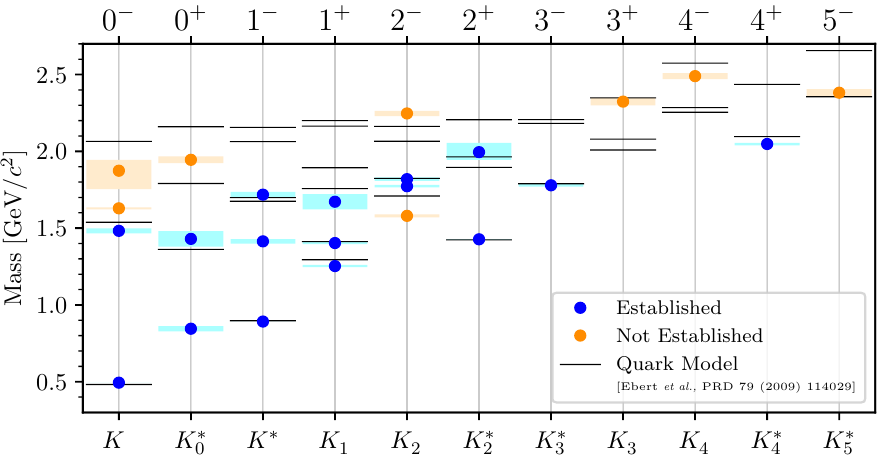
Figure 1: Strange-meson spectrum grouped by the J P quantum numbers of the states. The blue data points show the masses of established states, the orange data points those of not established states as listed by the PDG [1]. The similarly colored boxes represent the corre- sponding uncertainties. The black horizontal lines show the masses of states as predicted by the quark-model calculation in ref.